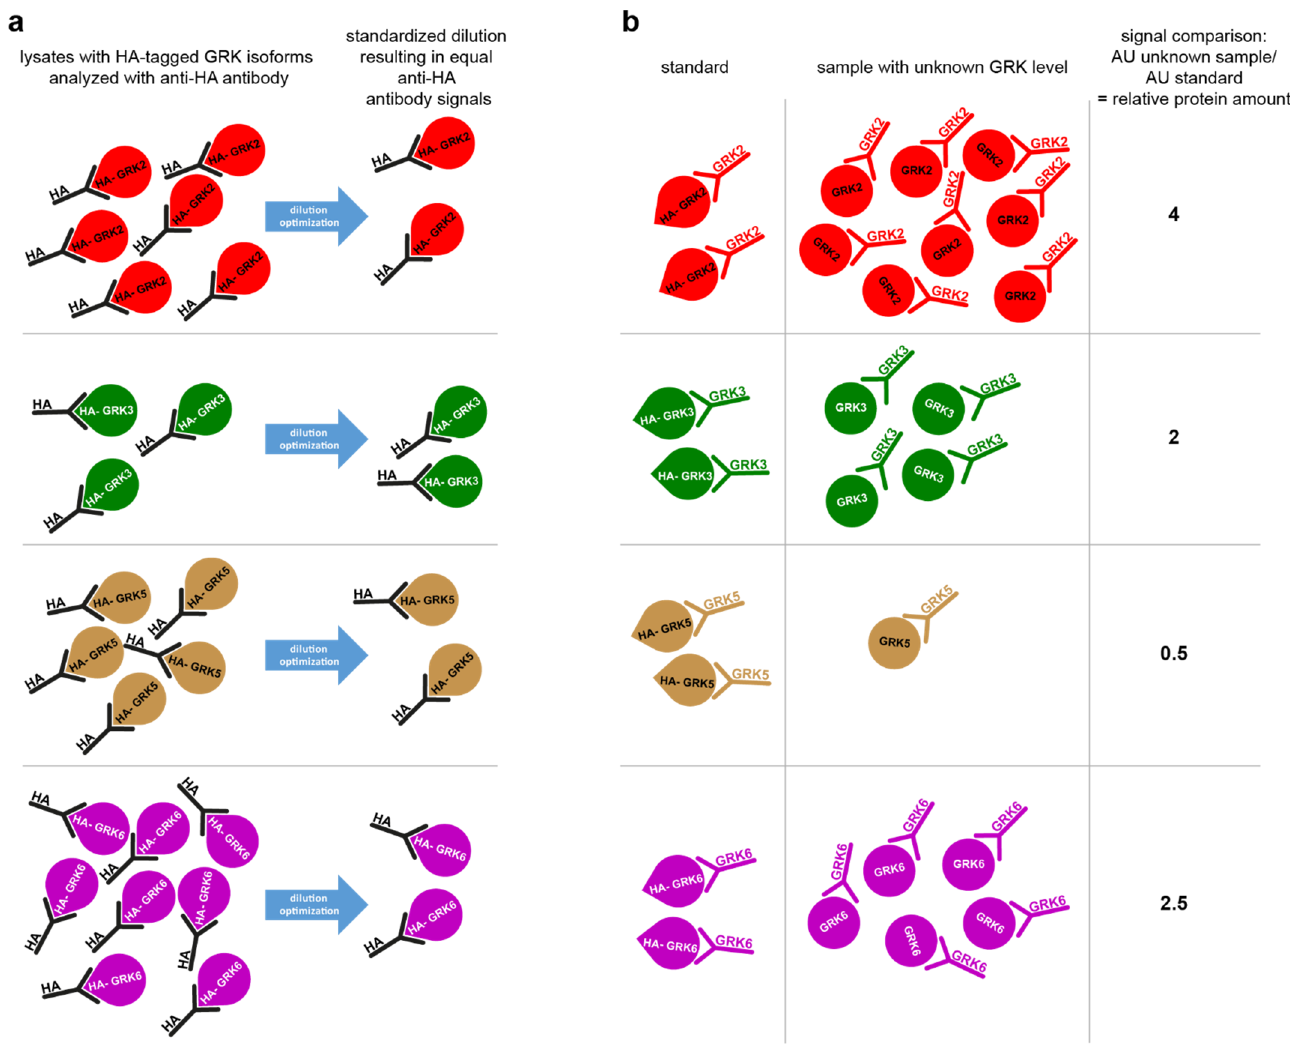
Figure 3. Simple tag-guided analysis of relative protein abundance (STARPA). Schematic depiction of STARPA implementation ( a ) and functionality ( b ). The creation of a protein standard for each GRK isoform containing equal amounts of HA-tagged GRK ( a ) enables the analysis of relative GRK levels via Western blot in any sample containing untagged GRK using GRK isoform-specific antibodies ( b ). AU, arbitrary units.